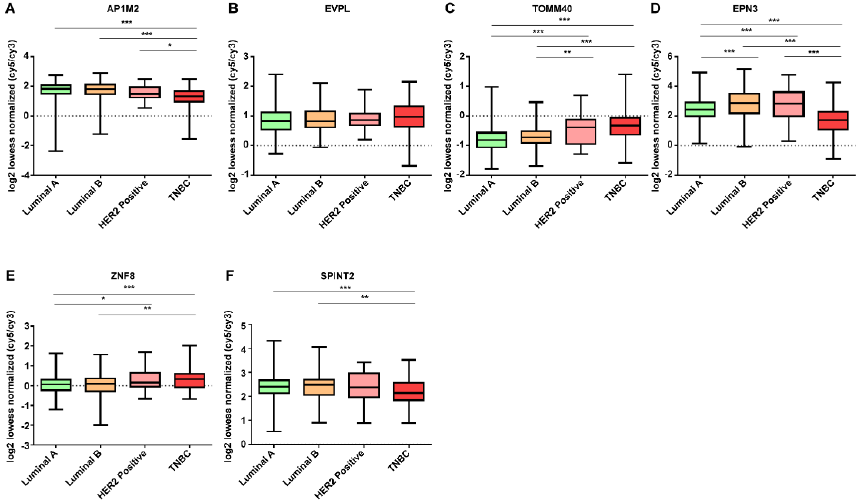
Figure 8. Expression patterns of DE mRNAs upregulated in breast cancer tissue according to molecular subtypes. ( A ) AP1M2, ( B ) EVPL, ( C ) TOMM40, ( D ) EPN3, ( E ) ZNF8, and ( F ) SPINT2. Data are reported as mean ± SD. * p < 0.05, ** p < 0.01, *** p < 0.001.